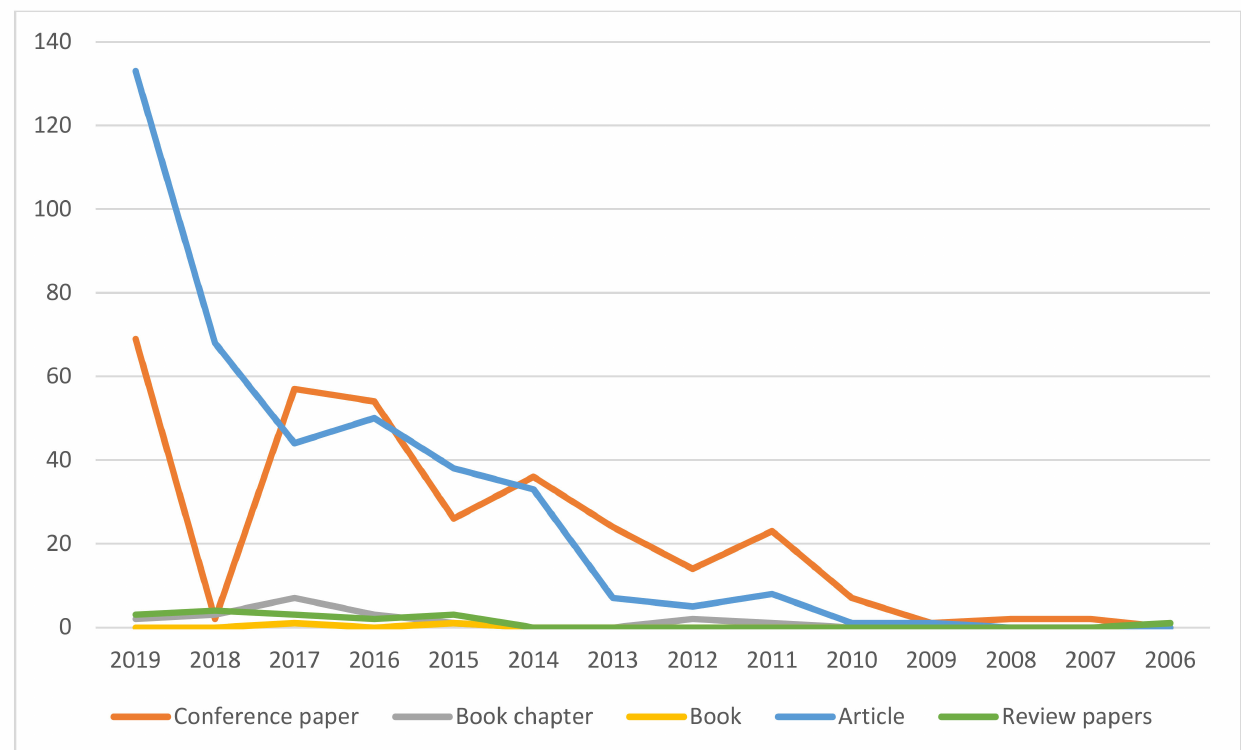
Figure 5. Annual BIM publications based on document